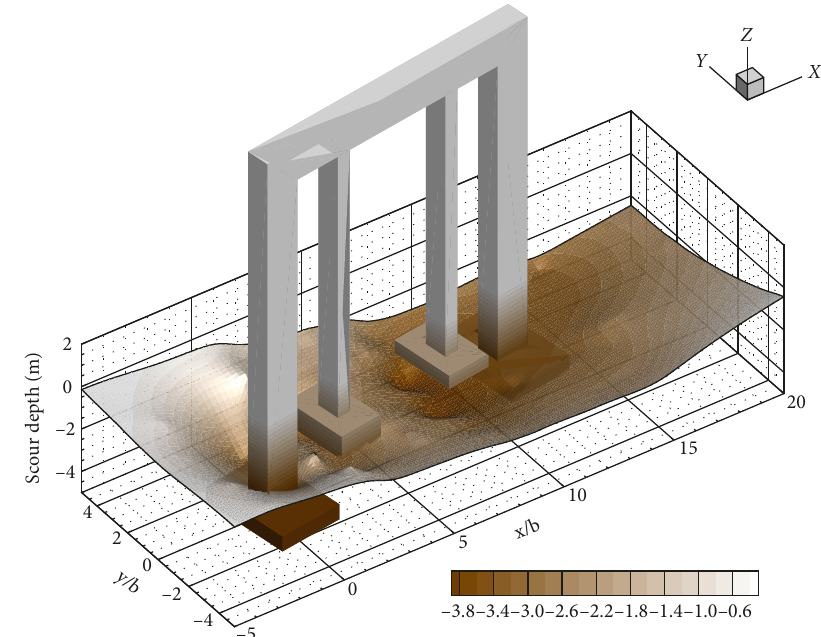
Figure 5: Scour depth contours for experimental run CR4. Figure 8. The HEC-18 formula includes the effect of the approach Froude number but does not include the pa- /V rameter bearing the effect of V . Conversely, the other 1 c two formulas, the Melville and the Sheppard et al. formulas, /V include the effect of V but do not consider the approach 1 c Froude number. Also, the Melville and Sheppard et al. /b because the relative formulas include a reduction in d s sediment size, b/d , is less than 25. The effect of the relative 50 /b , has an effect only in the HEC-18 formula flow depth, y 1 /b is large enough that it has almost because the value of y 1 no influence in the Melville and Sheppard et al. formulas.